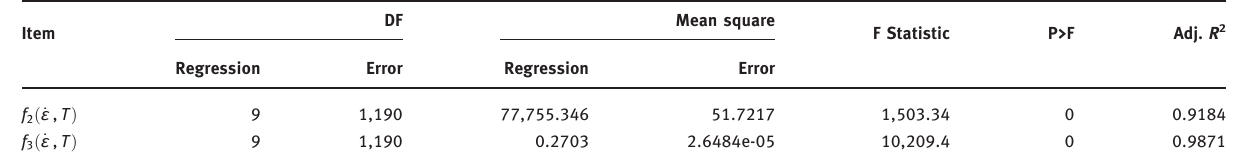
Table 16: Analysis of variance for f 2 ð _ ε , T Þ and f 3 ð _ ε , T Þ at low temperature region. DF Mean square Item Regression Error Regression